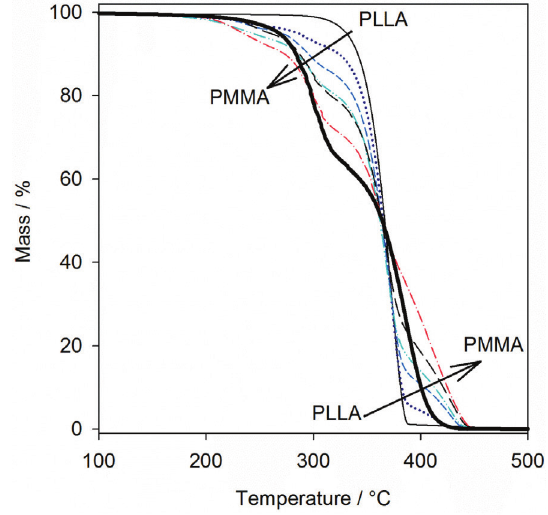
Fig. 9 – TG curves of pure PLLA, PMMA, and PLLA/PMMA blends, investigated under a stream of nitrogen at 10